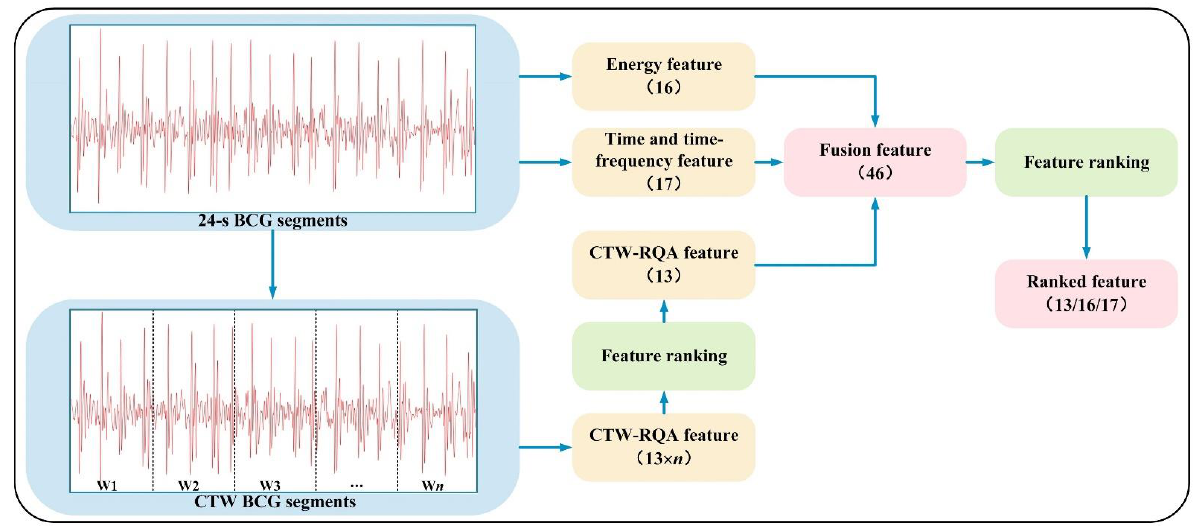
Figure 5. The extraction process of the proposed fusion features and ranked features.